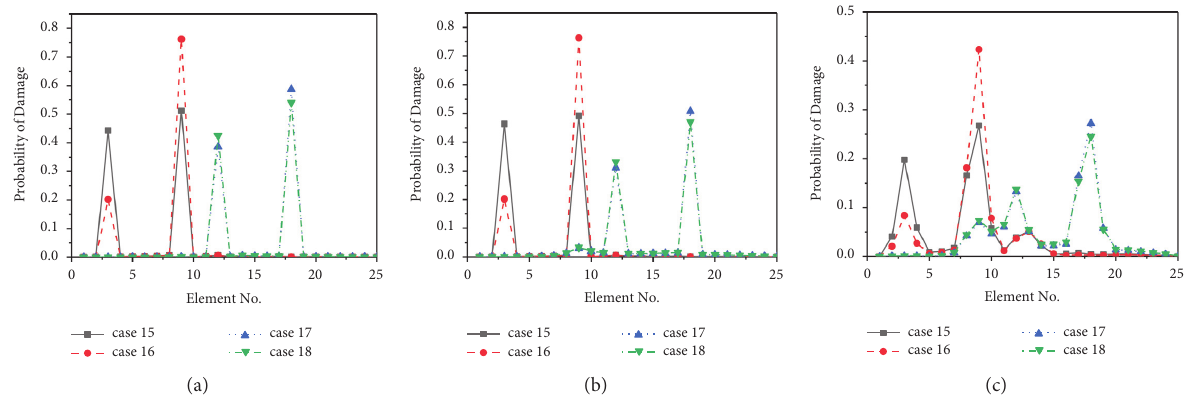
Figure 10: Fusion recognition results of two damage cases for DR